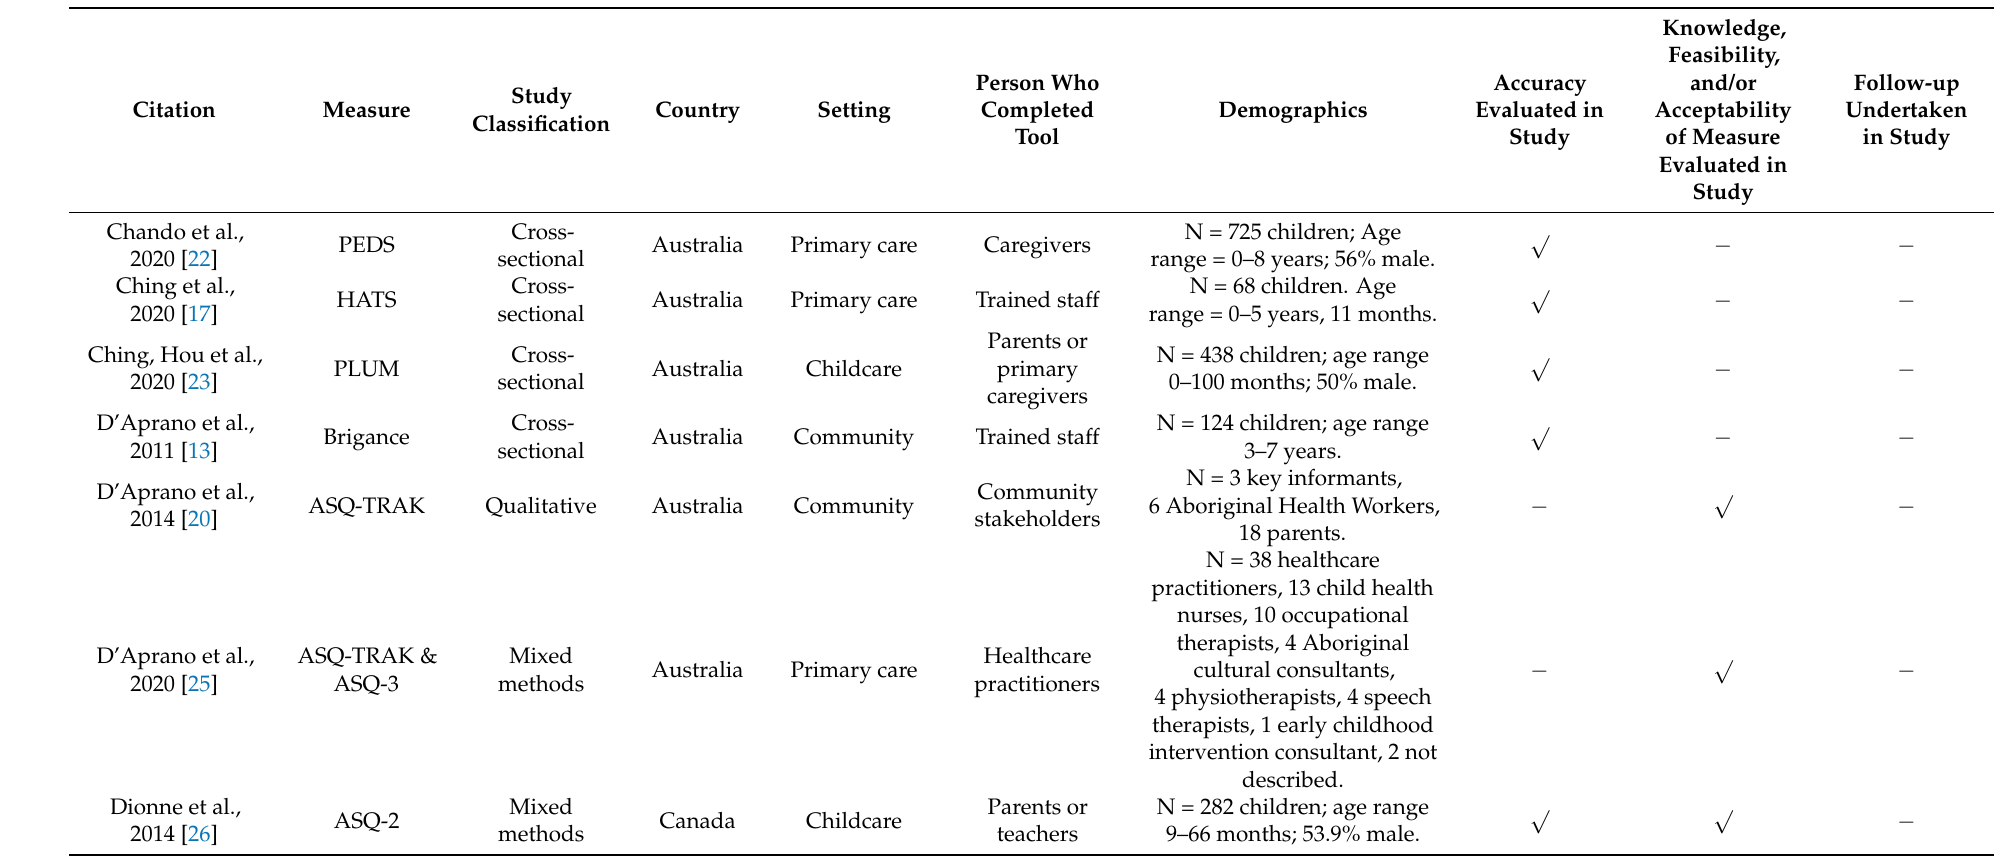
Table 3. Overview of studies included in the